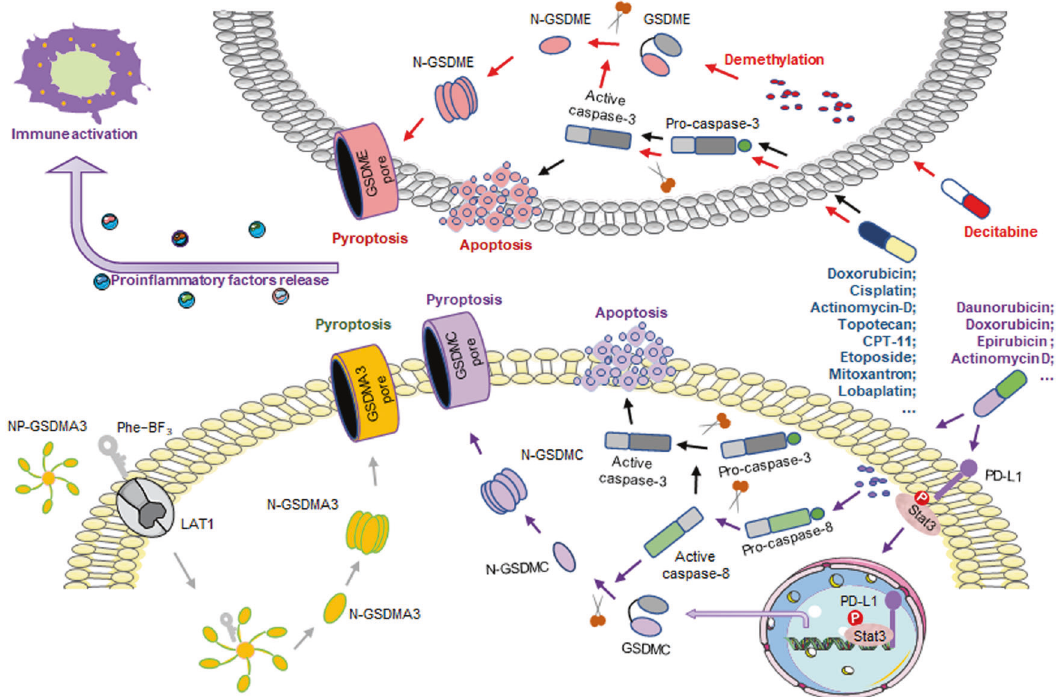
Fig. 4 Current status of gasdermin-mediated tumor therapy. The desilylation of Phe-BF3 releases gasdermin from NP-GSDMA3 and induces pyroptosis. A bioorthogonal chemical system was developed in which Phe-BF3 can enter cells through LAT1 (a Phe-BF3 transporter), desilylate and cleave the design linker containing a silyl ether. The puri fi ed GSDMA3 (N + C) is conjugated with nanoparticles to become NP-GSDMA3. When Phe-BF3 binds to nanoparticles, the desilylation catalyzed by Phe-BF3 can release active gasdermin from the conjugated nanoparticles and selectively release active gasdermin. Chemotherapeutic drugs induce caspase-3-mediated pyroptosis in tumor cells with high GSDME expression and apoptosis in tumor cells with low expression of GSDME. Decitabine is an inhibitor of DNA methyltransferase, which can demethylate GSDME, changing GSDME expression from low to high, and shift apoptosis to pyroptosis. Almost all chemotherapeutic drugs can induce PD-L1 into the nucleus and promote the expression of GSDMC, but only the antibiotics such as daunorubicin, doxorubicin, epirubicin, and actinomycin D can also activate caspase-8, cause GSDMC cleavage and trigger pyroptosis. Pyroptosis is accompanied by the release of cytokines, which mediate the immune